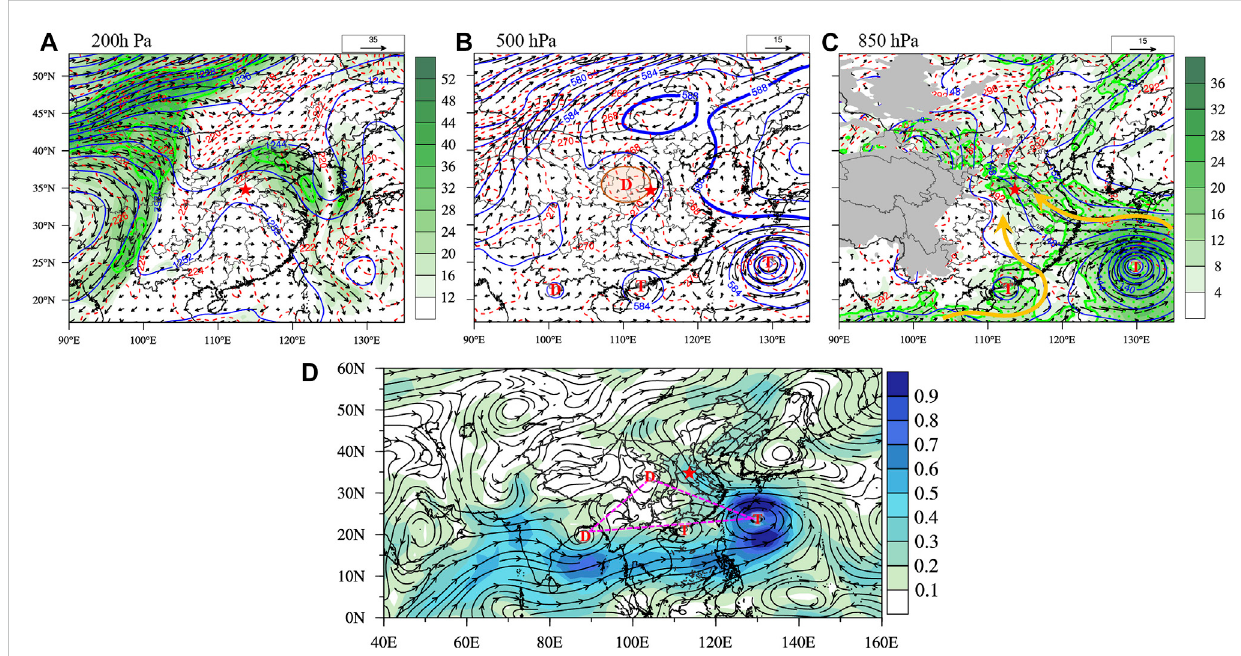
FIGURE 2 (A – C) 200, 500, and 850 hPa large-scale circulation fi elds at 0600 UTC July 20. The blue solid line represents the potential height (unit: gpm), the blue bold line indicates the isoline of 588 hPa, the red dashed line denotes the isotherm (K), the arrow means the vector wind (unit: m/s), color shading representswindspeed(unit:m/s),thegrayshadowsrepresenttheterrain,thetwoyellowarrowmeansthewestandeastmoisturebranch,andthecircled area of green dots is upper- and low-level jet areas. (D) Vertically integrated water vapor fl ux fi eld (unit: 10 3 kg m − 1 s − 1 ). The letters “ D ” and “ T ” represent the low-pressure center and typhoon, respectively, and the red pentagram represents the location of